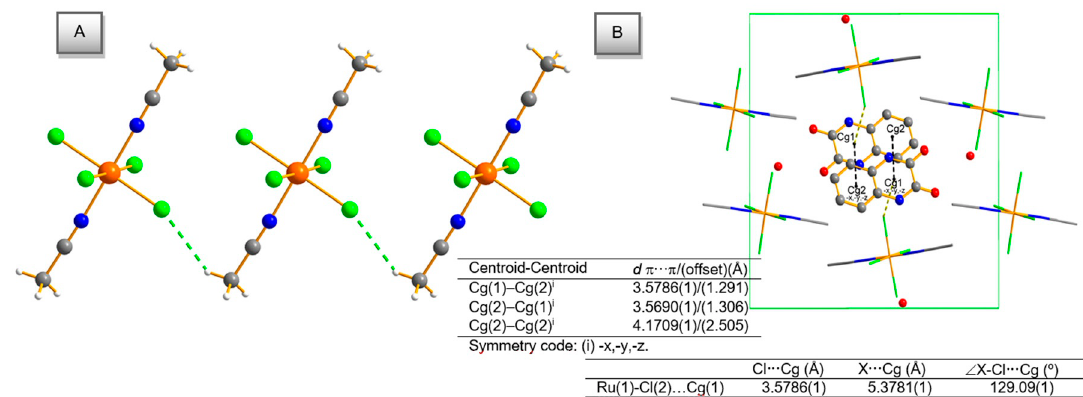
Figure 4. A packing diagram of complex 2 : ( A ) showing the zig-zag chains formed by the C-H ··· Cl hydrogen bonds; ( B ) a view of a channel filled with L 3 2, with marked Ru-Cl ··· π interactions and π ··· π stacking interactions (Cg(1): 6-membered ring defined by N(1), C(2), C(3), N(4), C(10), and C(9) atoms; Cg(2): 6-membered ring defined by C(5), C(6), C(7), C(8), C(9), and C(10) atoms).